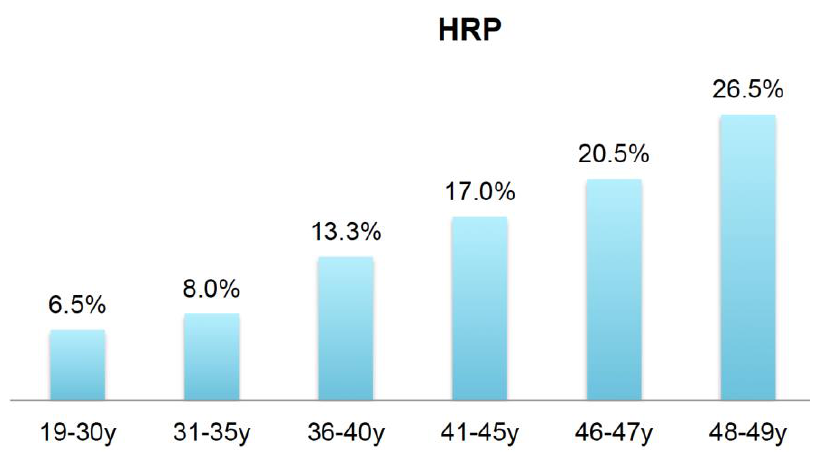
Figure 4. Vulnerable plaque features (high-risk-plaque—“HRP”) increased continuously with age.